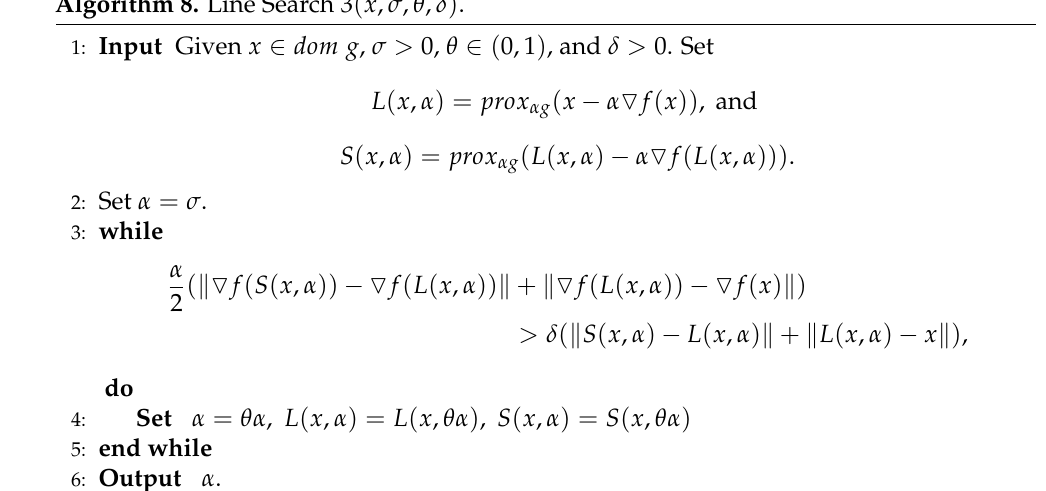
Algorithm 8. Line Search 3 ( x , σ , θ , δ )